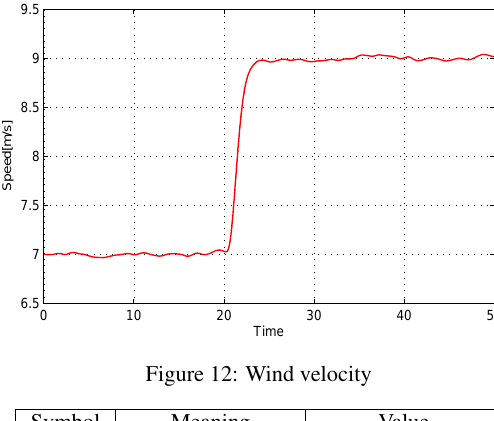
Figure 9: Earth relative position for different wind orientation